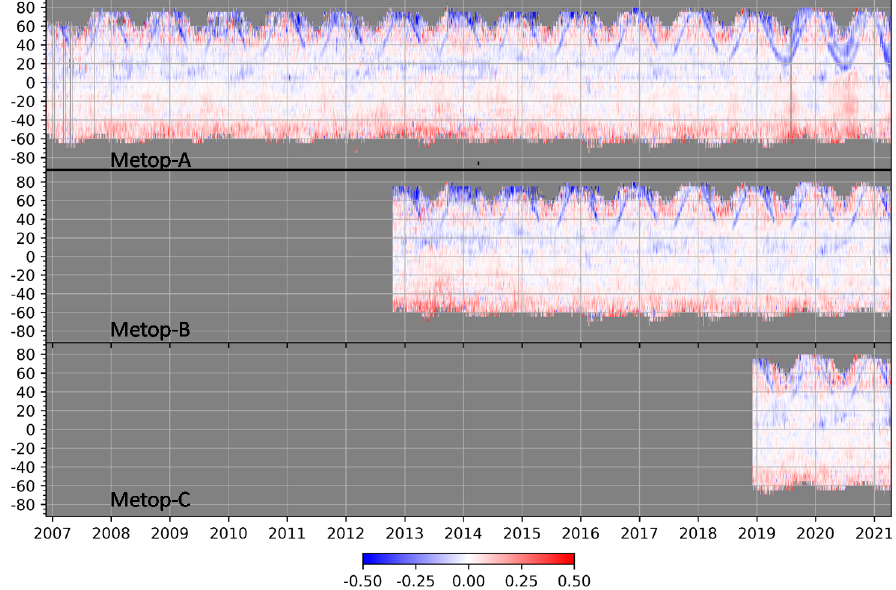
Figure 20. Same as in Figure 19 but for nighttime PWR – (D+TM) SST.